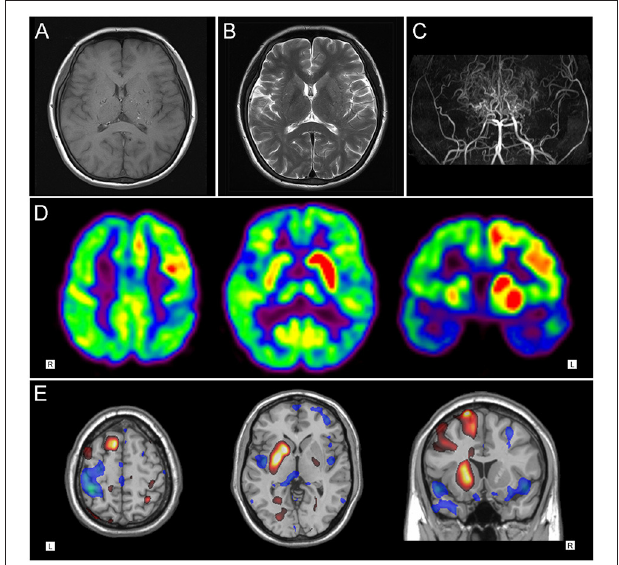
FIGURE 1 | Neuroimaging findings in patient 1. (A) T1-weighted and (B) T2-weighted axial cranial magnetic resonance imaging showed multiple flow-voids on both basal ganglia. (C) Magnetic resonance cerebral angiography revealed severe stenosis in the proximal circle of Willis, with numerous collateral vessels. (D) 18 F-FDG PET images and (E) statistical parametric mapping analysis showed hypermetabolism in the left striatum and fronto-parietal cortex, with slight hypometabolism in the left temporal